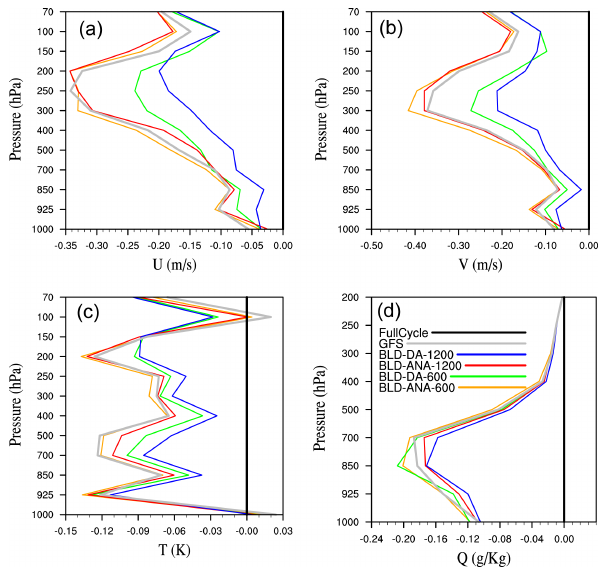
Figure 4. RMSD reduction compared to FullCycle at analysis time. (a) u , (b) v , (c) T , and (d) q .